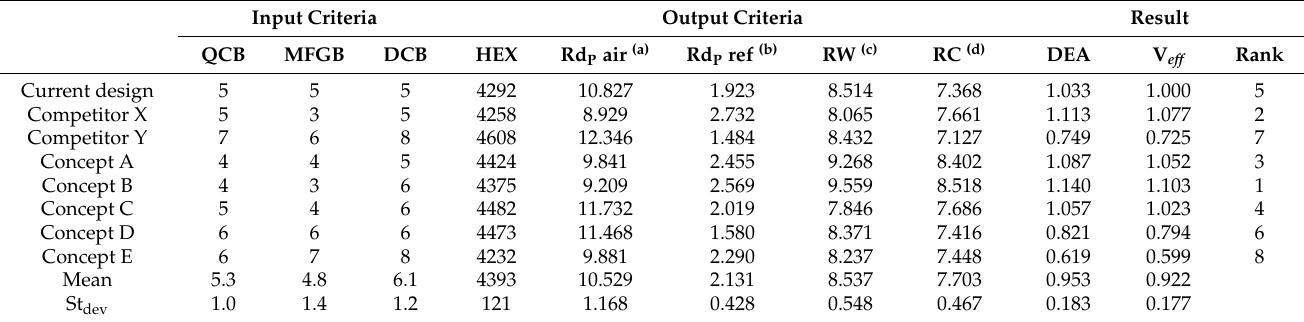
Table 5. Design development efficiency scores and